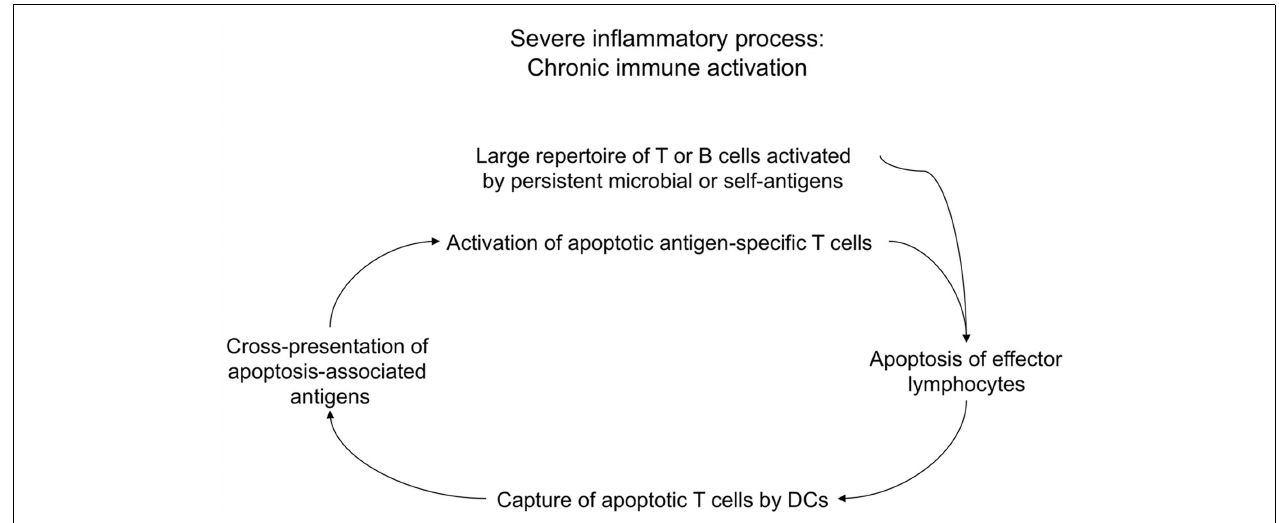
cross-prime a huge repertoire of autoreactiveT cells specific for a multitude of apoptotic cell-associated epitopes. Apoptotic antigen-specificT cells participate to the maintenance of chronic immune activation via their effector performances, then they will undergo apoptosis, and the resulting apoptotic cells will be cross-presented by DCs that will cross-prime new waves of apoptotic antigen-specificT cells, and so